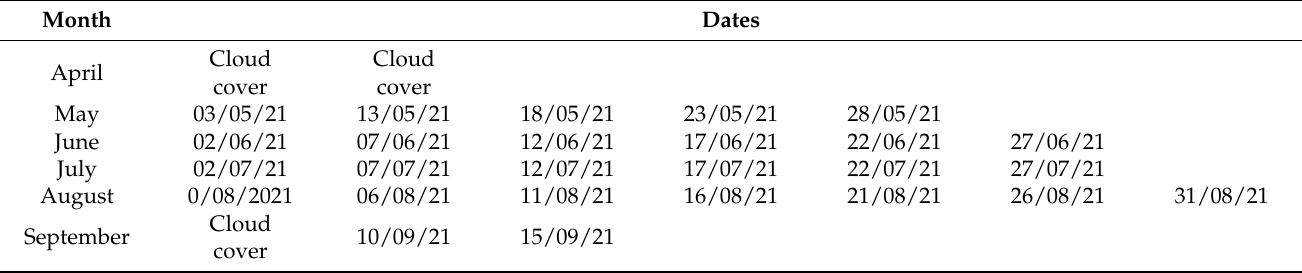
Table 1. Acquisition dates of satellite data for the 2021growing season.